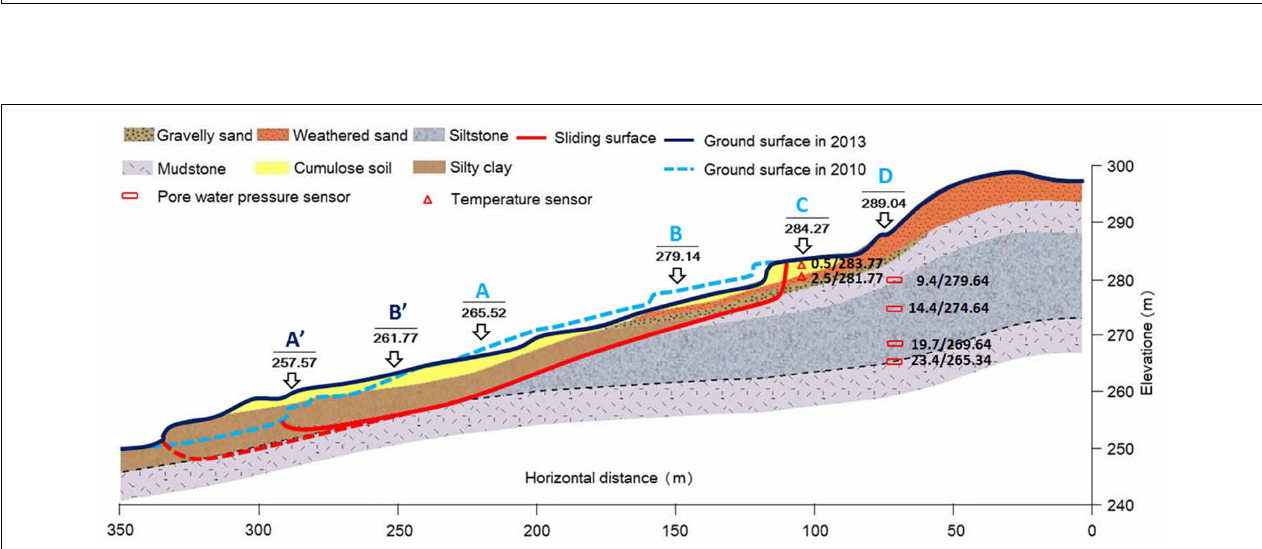
FIGURE 8 | Distribution of the drillings, the geophysical measurement lines and points for monitoring displacement, ground temperature, and pore water pressure in Landslide K178 + 530.